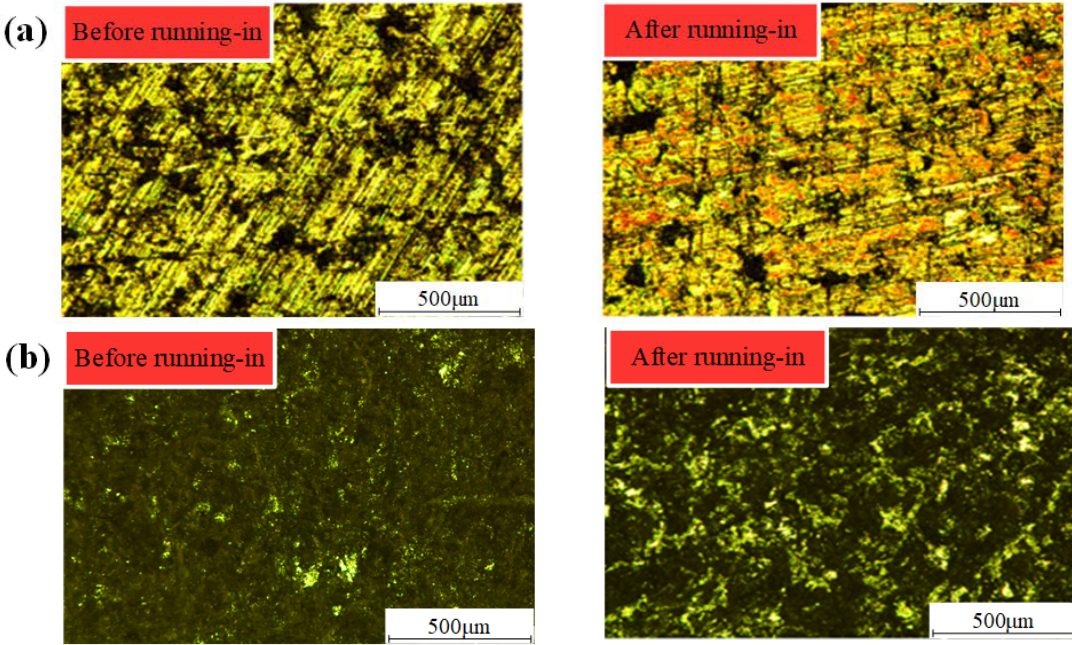
Figure 4. Metallographic micrograph of the disc before and after the running-in process ( a ) copper-based friction material (CFM); ( b ) paper-based friction material (PFM).